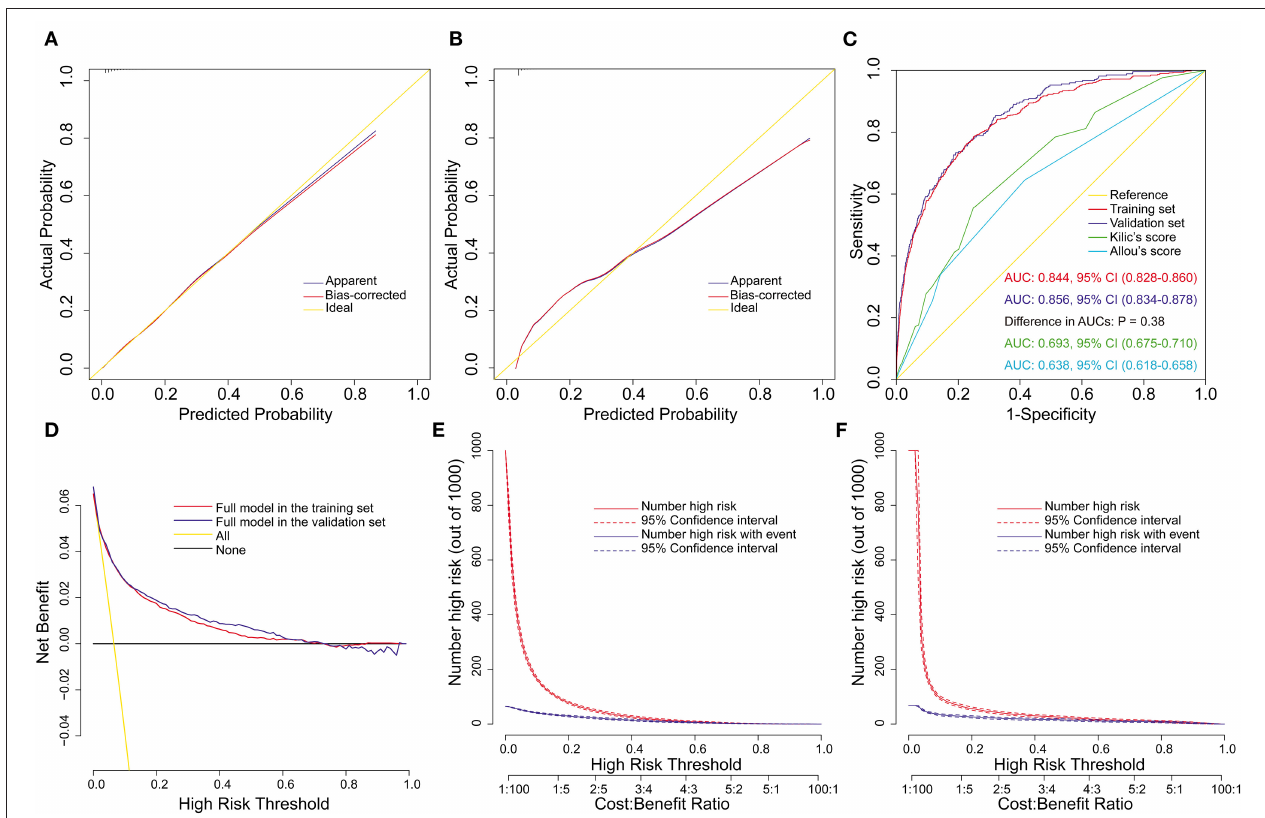
FIGURE 3 | Assessment of the full nomogram model for POP after ECS. Calibration plots in the training set (A) and the validation set (B) , ROC curves in the two sets and comparison with previous models (C) , decision curves in the two sets (D) , and clinical impact curves in the training set (E) and the validation set (F) . AUC, area under the receiver operating characteristic curve; CI, confidence interval; ECS, elective cardiac surgery; POP, postoperative pneumonia; ROC, receiver operating characteristic curve.